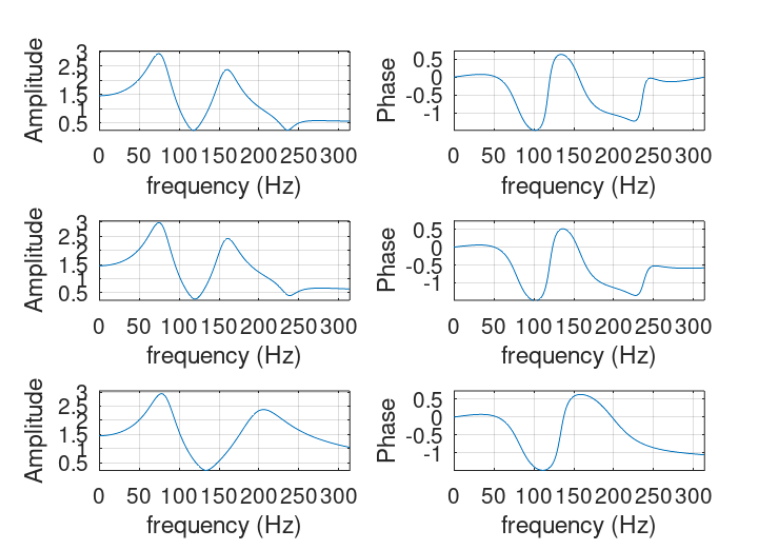
Figure 8. Comparison of original and transformed frequency responses with T = 0.01.